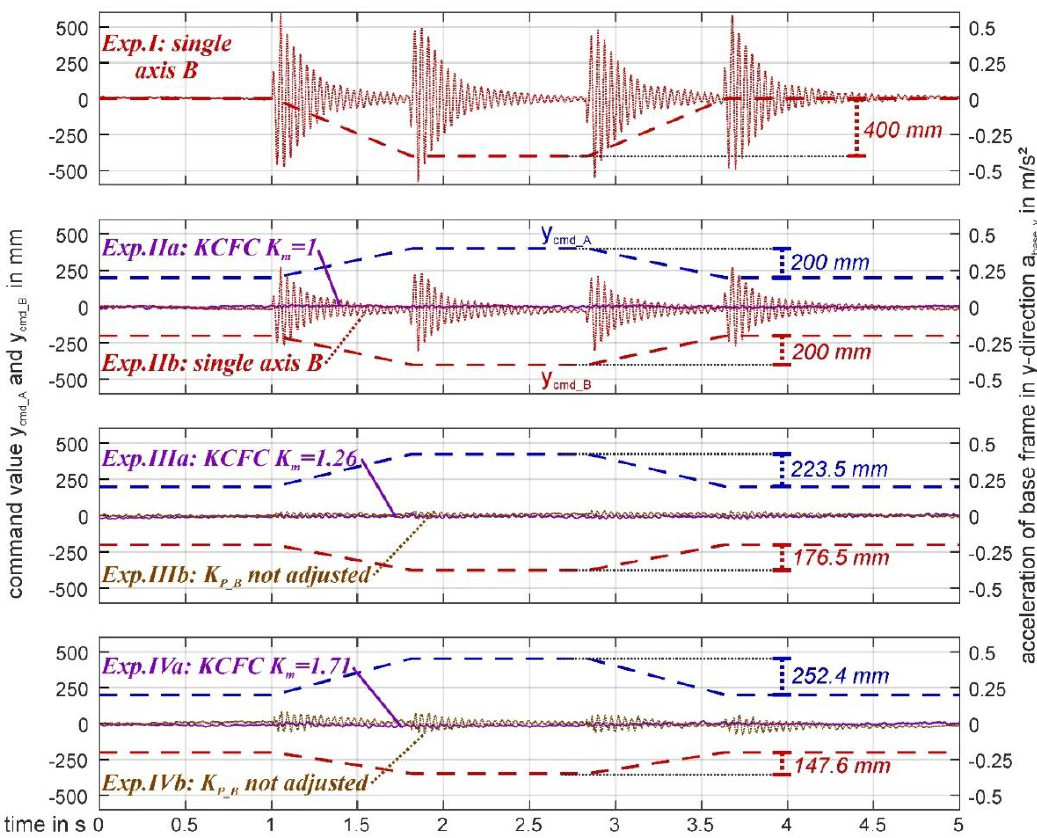
Figure 3. Experimental results for the parameter sets I to IVb as shown in Table 3 [14].